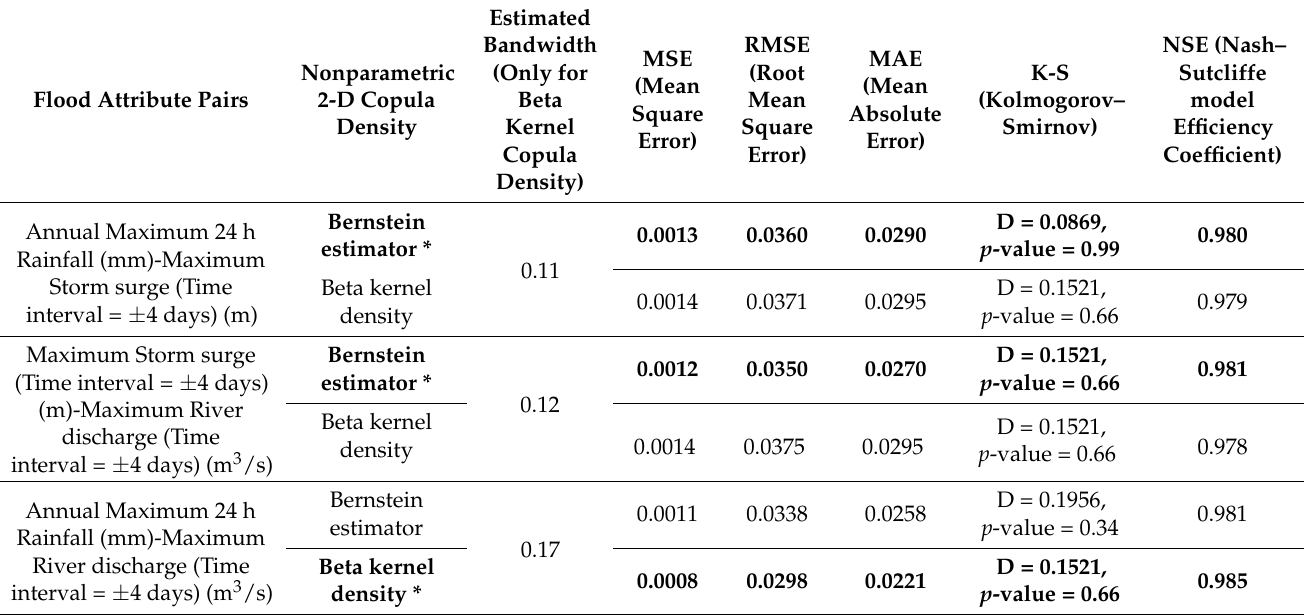
Table 3. Fitting the nonparametric 2-D copula density and their goodness of fit (GOF) test to the given flood attribute